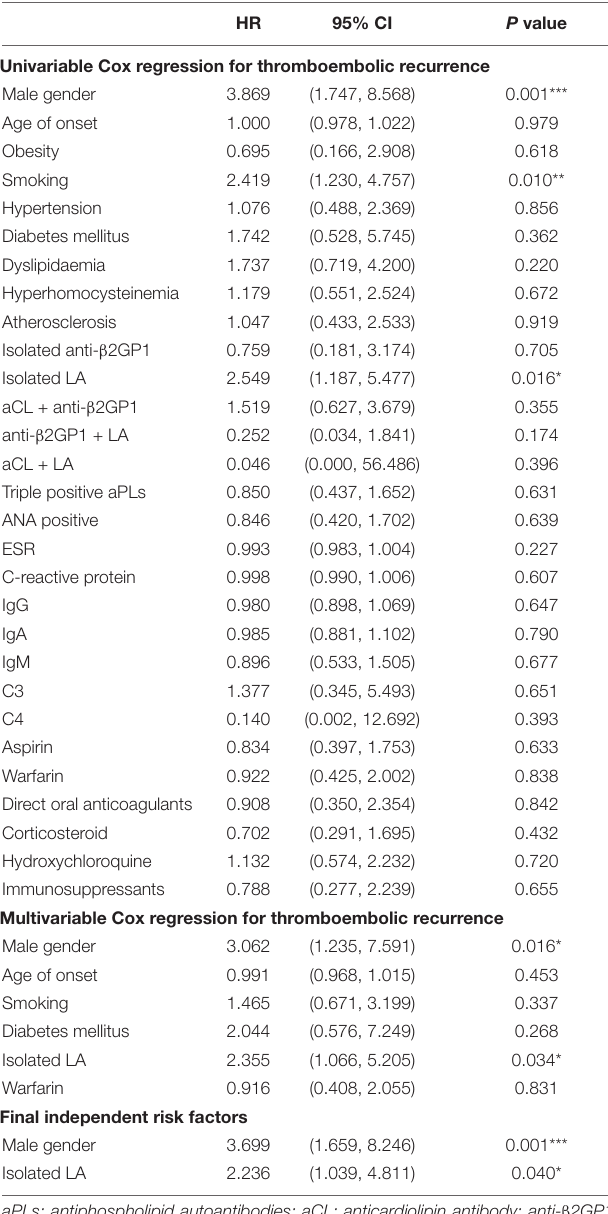
TABLE 4 | Univariable and multivariable Cox regression for thromboembolic recurrence in patients with primary thrombotic antiphospholipid syndrome (ptAPS). HR 95%